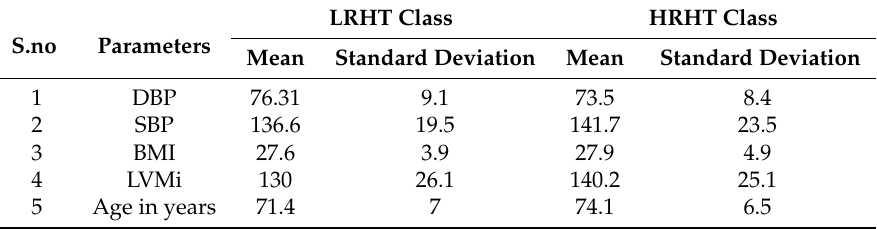
Table 2. Statistics of the patients employed in acquiring the database. LRHT, low-risk hypertension; HRHT, high-risk hypertension.